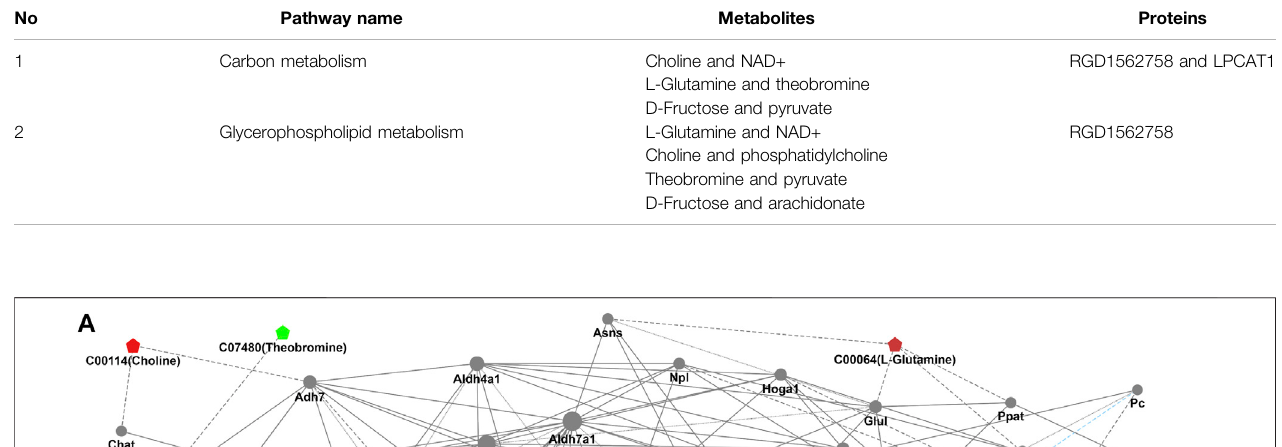
TABLE 3 | Signi fi cantly altered pathways with differentially expressed metabolites and proteins.